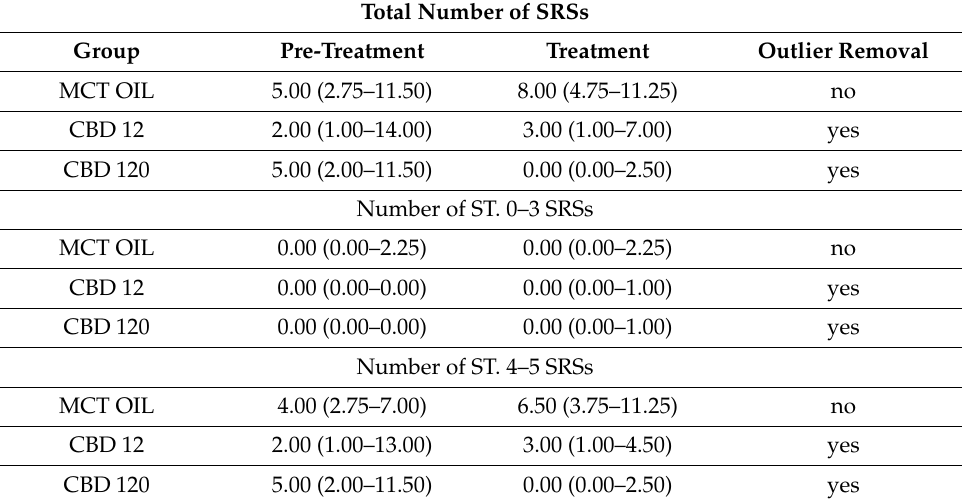
Table 1. Median and interquartile range values of the number of spontaneous recurrent seizures (SRSs) in the various treatment groups with cannabidiol (CBD) at 12 mg/kg, 120 mg/kg, or with medium ‐ chain triglyceride (MCT) oil, subdivided by stages (ST.), or considered altogether. Ten animals per group were included, except where a single outlier per group was identified and re ‐ moved.